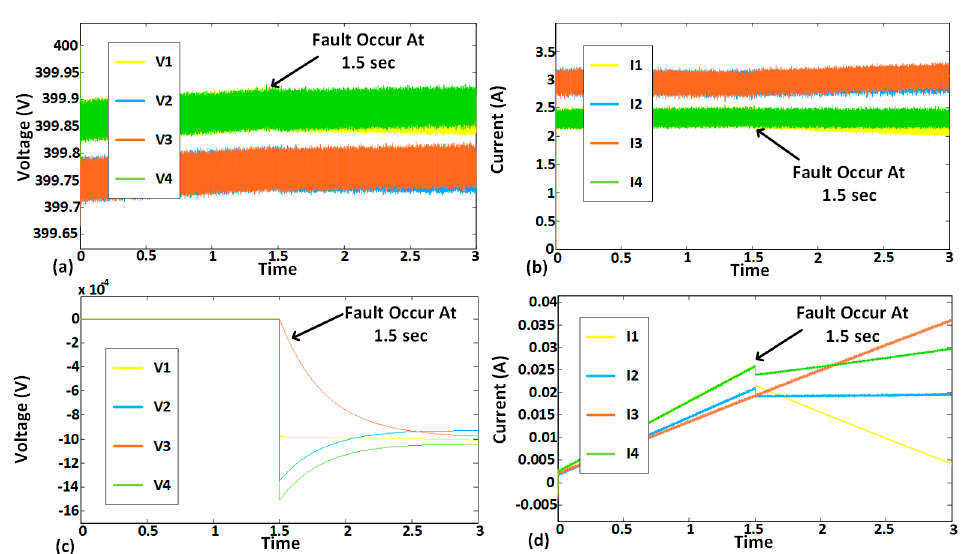
Figure 7. Different scenarios for DC MG. Electronics 2018 , 7 , x FOR PEER REVIEW